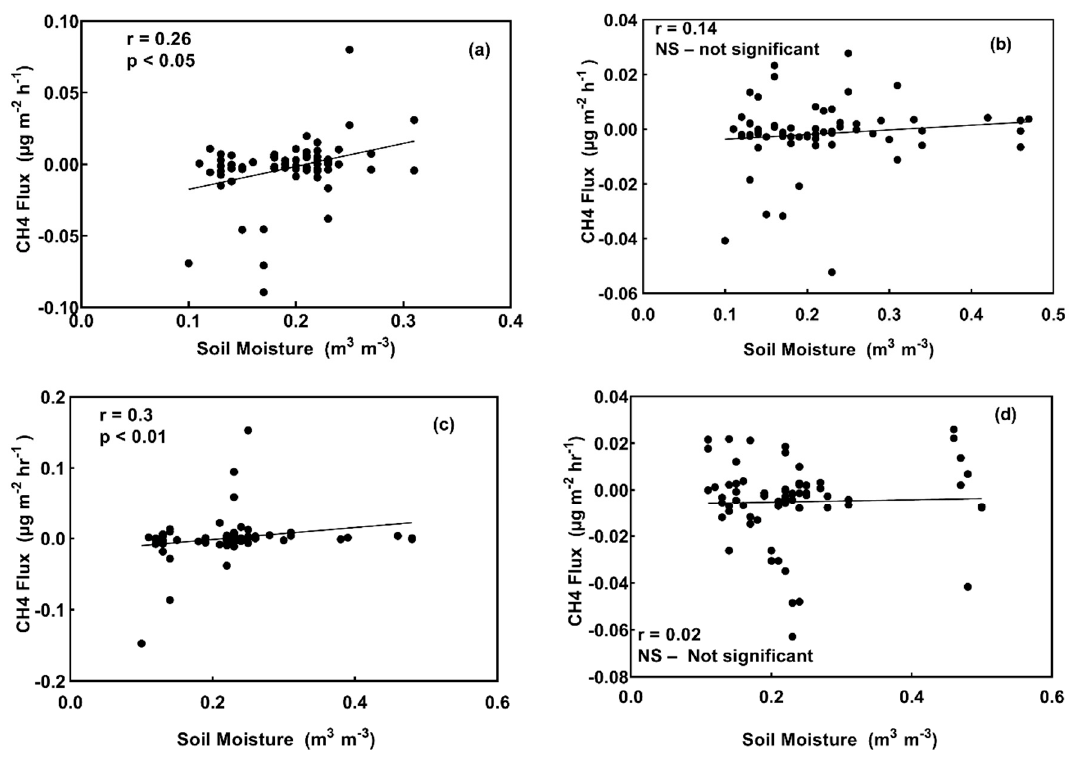
Figure 9. CH 4 fluxes vs. soil temperature at 10 cm in control treatment plots ( a ), and plots treated with urea ( b ), digestate ( c ), and hydrochar ( d ).